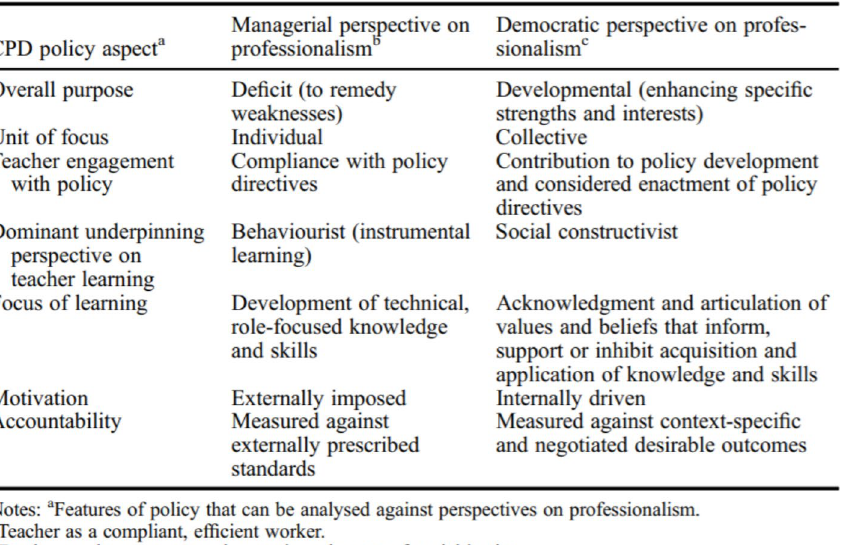
Fig. 1 A guideline that teachers used to outline aspects of CPD policies against perspectives of professionalism. Adopted from Kennedy’s (2014, p. 965) analysis of CPD aspects that student-teachers used to guide their under- standing of CPD in the second evaluation